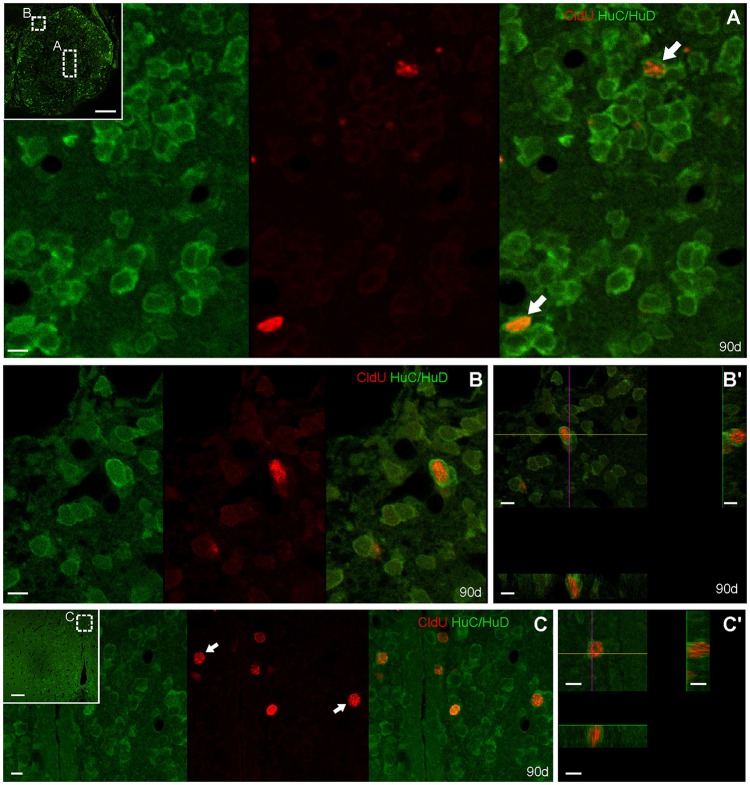
Neuronal differentiation in the olfactory bulb and rostral subpallium at 90 days after four daily injections of CldU demonstrated by co-localization with HuC/HuD. Confocal microphotographs of the olfactory bulb (A,B,B′) and the rostral subpallium (C,C′) at the level indicated by the dotted rectangles in the panoramic view (insets) to evidence double labeled cells. HuC/HuD and CldU labeling are shown in green and red channels of single scans, respectively. Co-localization is confirmed by the overlay of both channels, or by the x-z and y-z orthogonal projections of stacks obtained from 19 planes, every 0.5 μm (B′), or 15 planes, every 0.5 μm (C′).